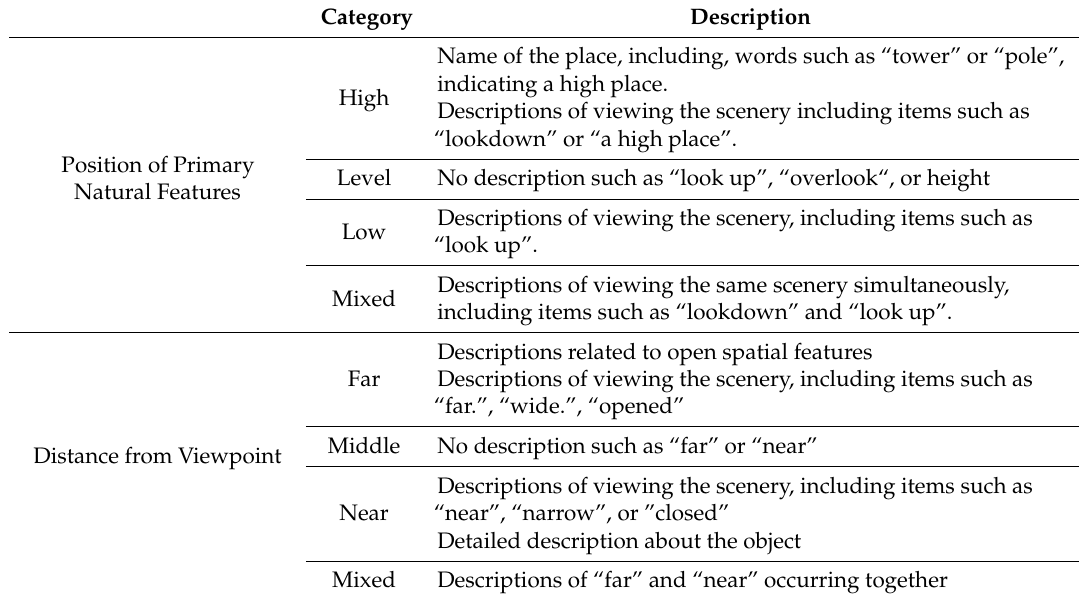
Table 3. The categories of the viewing method for the scenery and the corresponding description in the text. Category Description Name of the place, including, words such as “tower” or “pole”, indicating a high place. High Descriptions of viewing the scenery including items such as “lookdown” or “a high place”. Position of Primary Level No description such as “look up”, “overlook“, or height Natural Features Descriptions of viewing the scenery, including items such as Low “look up”. Descriptions of viewing the same scenery simultaneously, Mixed including items such as “lookdown” and “look up”. Descriptions related to open spatial features Far Descriptions of viewing the scenery, including items such as “far.”, “wide.”, “opened” Middle No description such as “far” or “near” Distance from Viewpoint Descriptions of viewing the scenery, including items such as Near “near”, “narrow”, or ”closed” Detailed description about the object Mixed Descriptions of “far” and “near” occurring